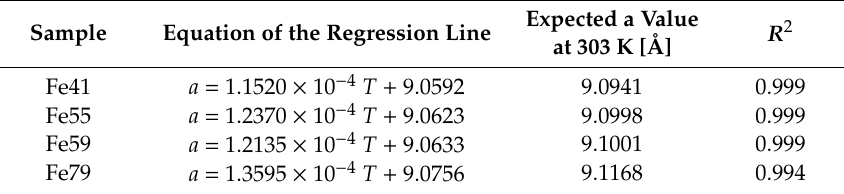
Figure 4. Trend of the skutterudite a cell parameter as a function of the temperature for each sample. The dashed lines are the regression lines fitting the experimental points; the error bars are hidden by data markers. Table 2. Equation of the regression lines a = m T + q fitting the a lattice parameter vs. the temperature ( T ) for each composition; the expected a values at 303 K and the calculated R 2 values are reported too.